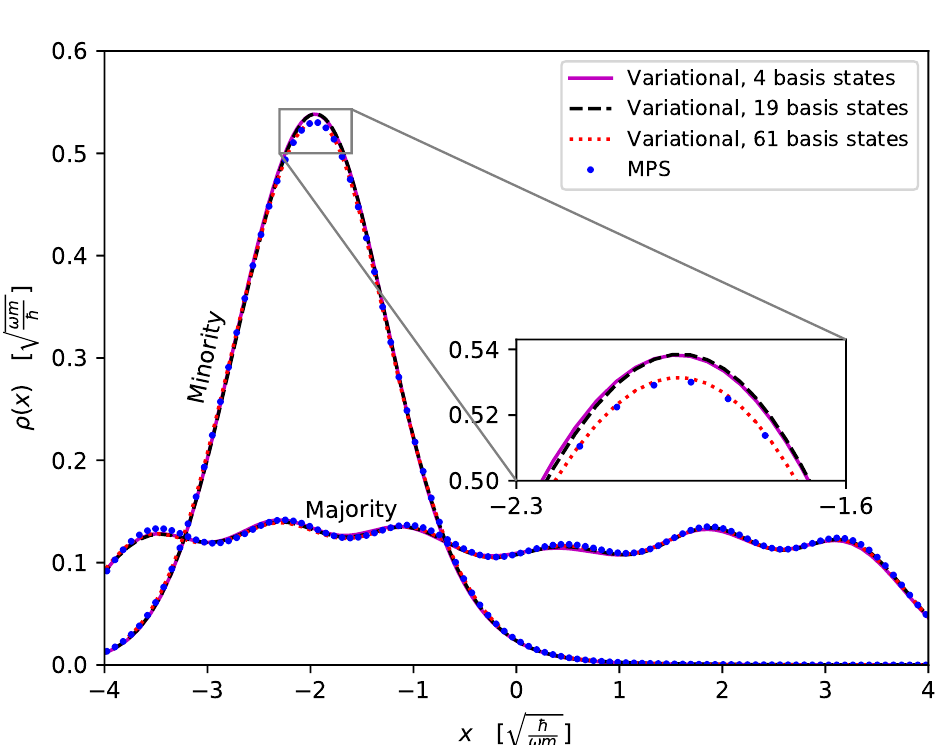
(cid:113) m = 1 in the double ħ h 3 ω